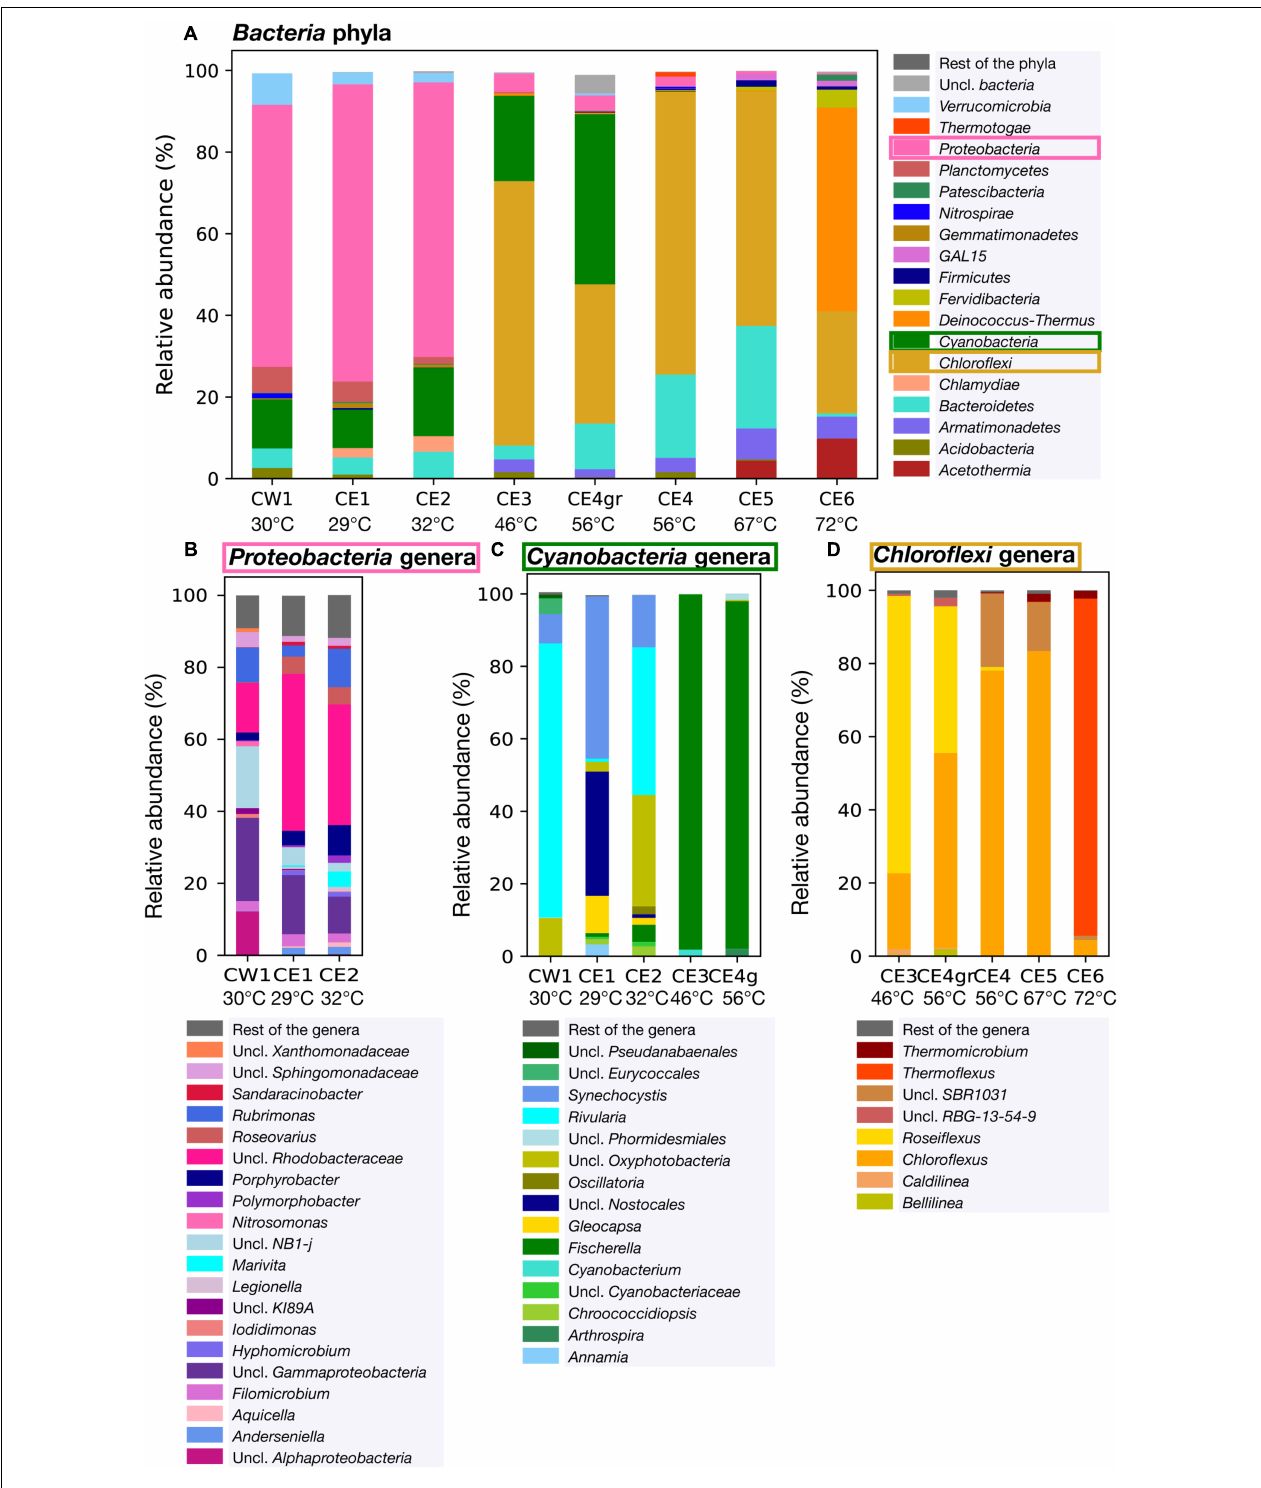
FIGURE 4 | Relative abundance of the bacterial community composition in the eight Cacao biofilms based on DNA sequencing. (A) Relative abundance of the bacterial phyla within the eight biofilms. (B) Relative abundance of Proteobacteria genera in the low-temperature biofilms ( ≤ 32 ◦ C), where the phylum was the most abundant. (C) Relative abundance of Cyanobacteria in biofilms of low and mid-temperature (from 29 to 56 ◦ C) at the genus level based on the 16S rRNA gene amplified with the specific primers for Cyanobacteria . Only the cyanobacterial profiles of the low temperature biofilms are shown, as this phylum was relatively more abundant in those samples. (D) Relative abundance of Chloroflexi in the mid to high-temperature biofilms (from 46 to 72 ◦ C) at the genus level. Uncl, unclassified.